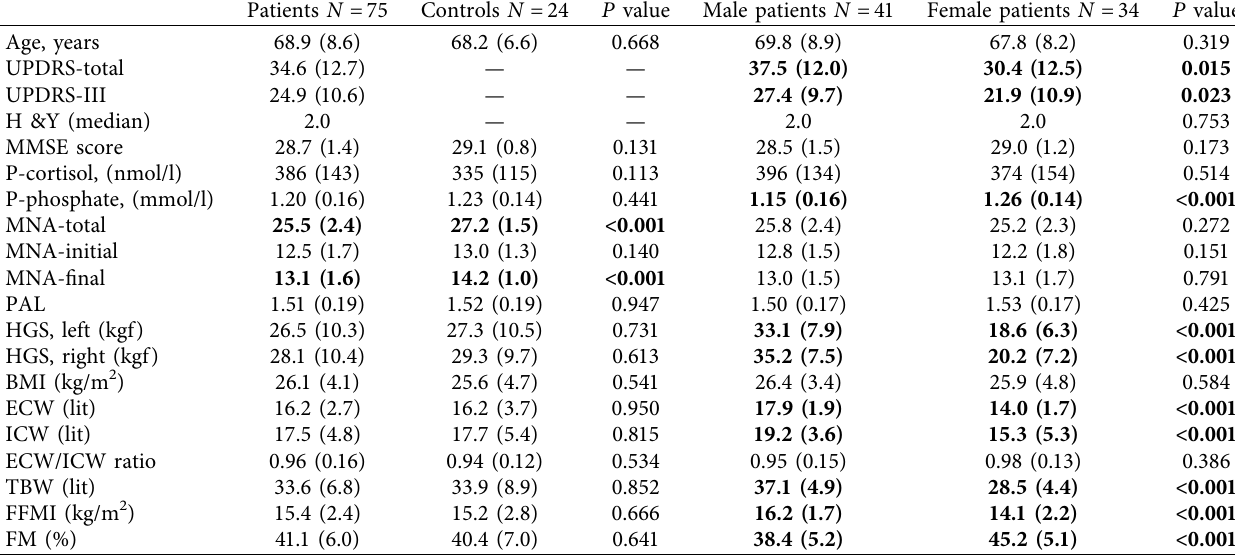
Table 1: Clinical characteristics and anthropometric indices of the study population, patients with PD, and controls and for male and female patients at time of PD